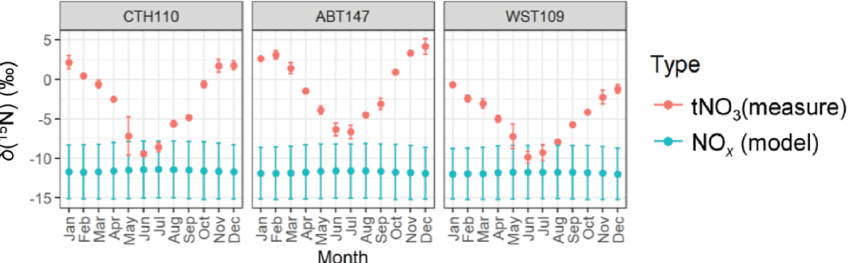
Figure 6. The monthly predicted δ ( 15 N, NO x ) from the emission estimates and the observed monthly average δ ( 15 N, tNO 3 ). The data points correspond to the mean, and the error bars correspond to the uncertainty, representing the propagated uncertainty for the modeled δ ( 15 N, NO x ) and the standard deviation for the δ ( 15 N, tNO 3 )